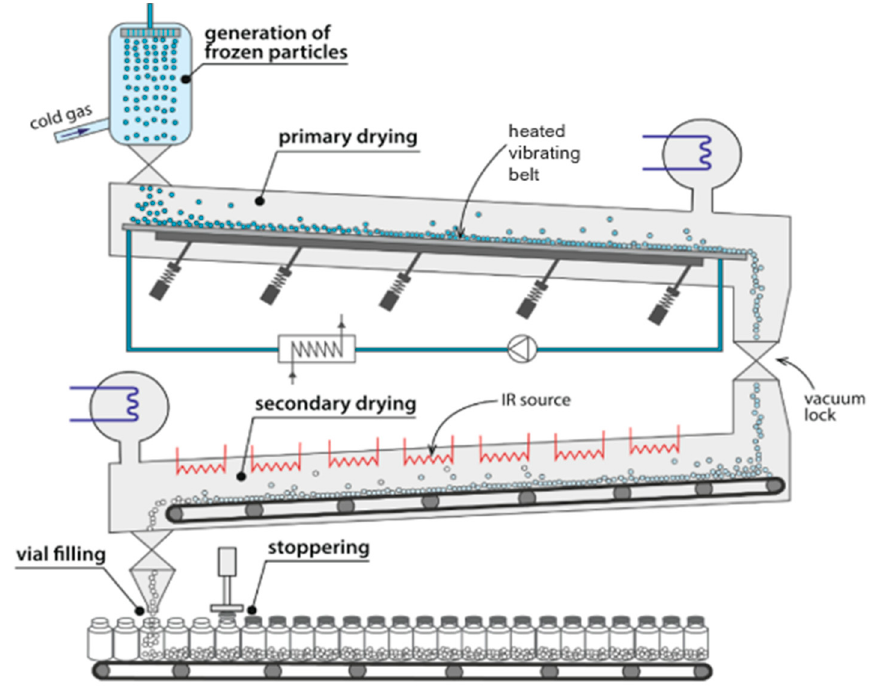
Figure 3. Illustration of the invention of Rey. Reprinted with permission from Pisano et al., Eur. J.